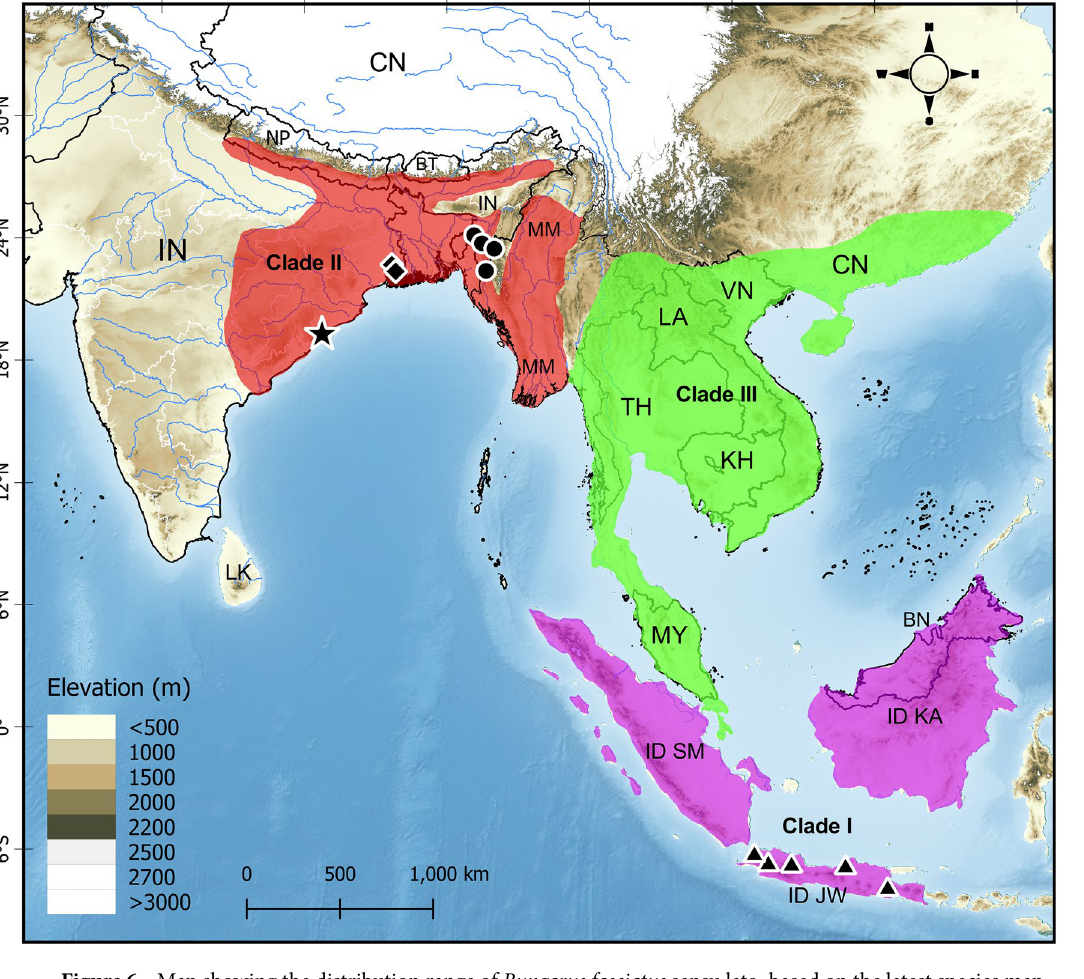
Figure 6. Map showing the distribution range of Bungarus fasciatus sensu lato , based on the latest species map provided by the World Health Organization (2022); the coloration corresponds to the three distinct evolutionary lineages recovered in the phylogenetic analyses. The type locality of Bungarus fasciatus sensu stricto is indicated by a black star. Localities of specimens used in the morphological analyses are indicated by black filled diamonds (WB), circles (MZ), and triangles (JV). Abbreviations for countries are: IN India, NP Nepal, BT Bhutan, BD Bangladesh, LK Sri Lanka, CN China, MM Myanmar, LA Laos, TH Thailand, VN Vietnam, KH Cambodia,